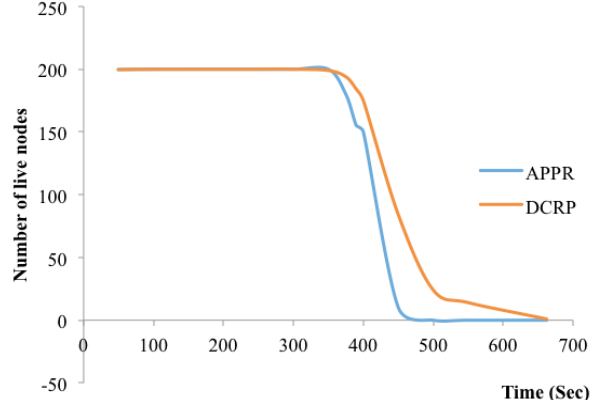
Fig. 9. Comparison between DCRP and PRRP protocols in terms of number of live nodes versus time. Table 3. Total energy versus Time for DCRP and PRRP Protocols Test No.